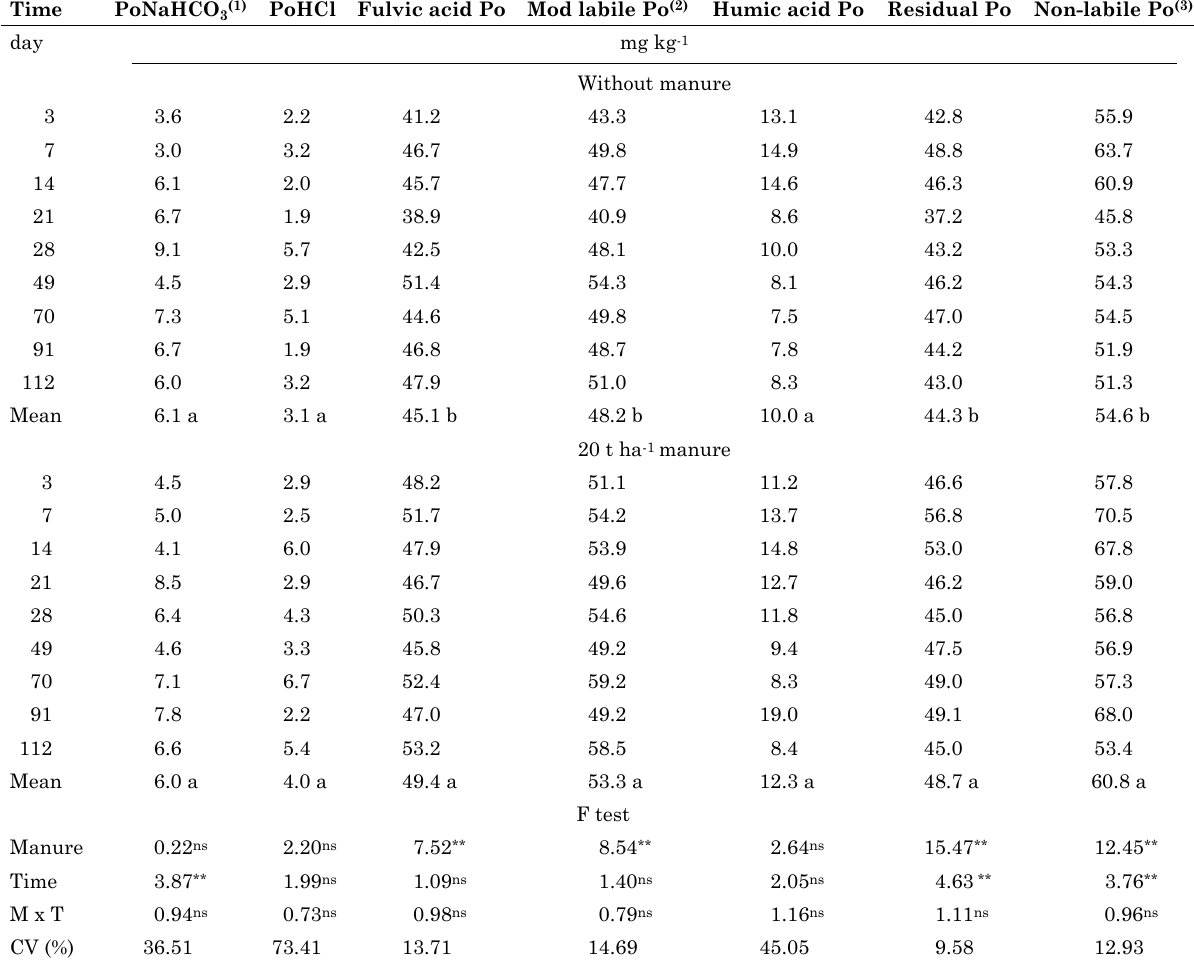
Table 3. Organic P fractions in a sandy-clay loam Haplustox fertilized or not with cattle manure, evaluated during 112 days of incubation